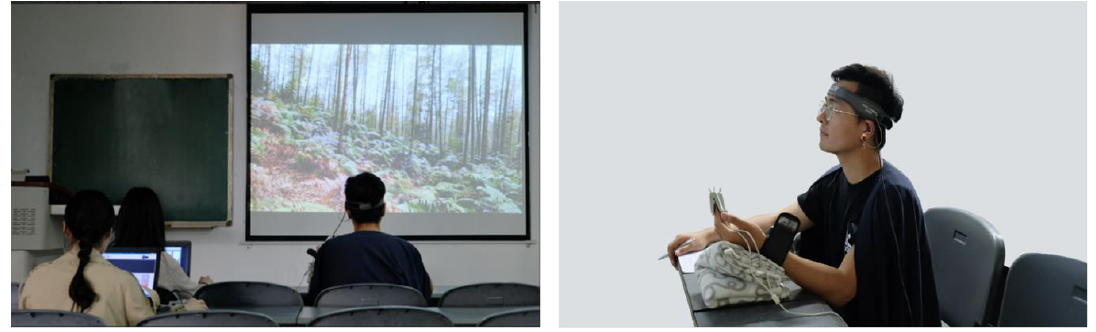
Figure 3. Experimental schedule for each participant. POMS, Profile of Mood States.